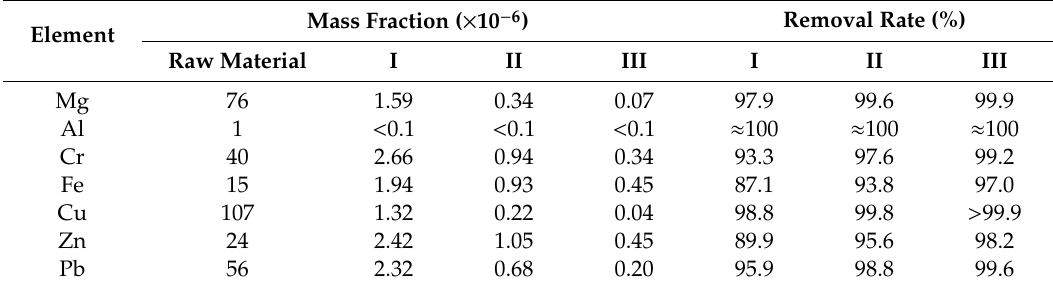
Table 2. Detection of impurity contents in raw gallium material and high purity purified gallium.